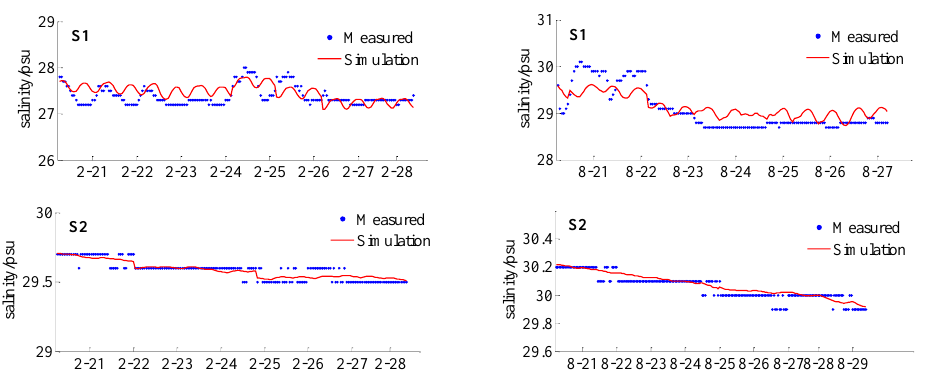
Figure 7. Verification of tidal current.